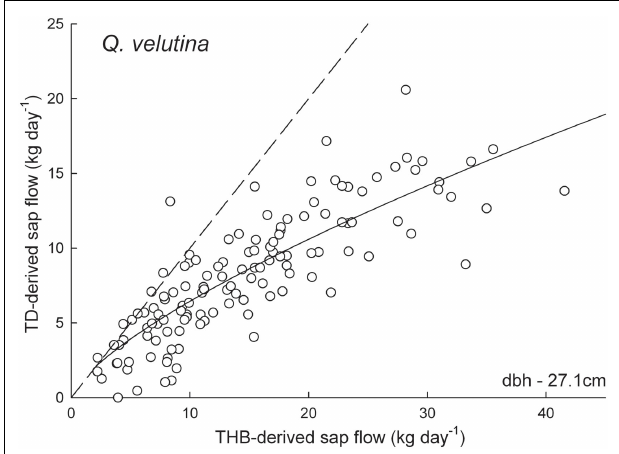
FIGURE 2 | Sap flow rates (kgday − 1 ) derived from the tissue heat balance (THB) system and thermal dissipation (TD) system using 2-cm long sensors in a 27.1-cm dbh Q. velutina individual. The dashed line is the one to one line and the solid line is the best fit regression ( y = 1.24 × x 0.72 , r 2 = 0.71). Sapwood depth was calculated to be over 2cm therefore original 2-cm length sensor data are shown.